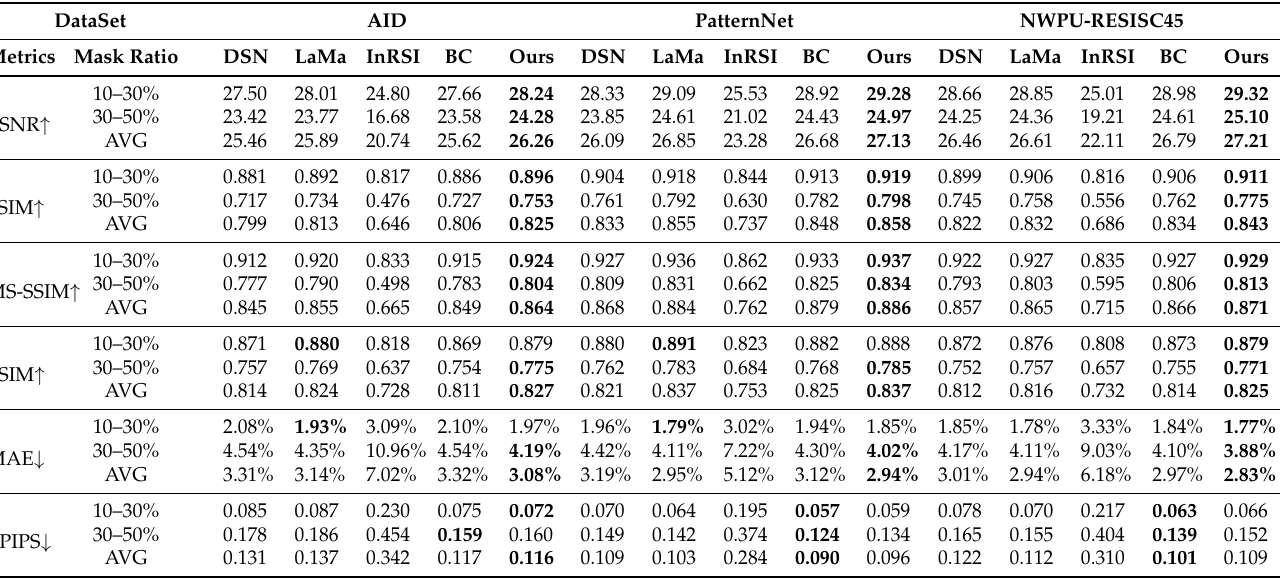
Table 4. Quantitative results with DSN [5], LaMa [44], InRSI [2], BC [43], and ours on AID, PatternNet, and NWPU-RESISC45 datasets.